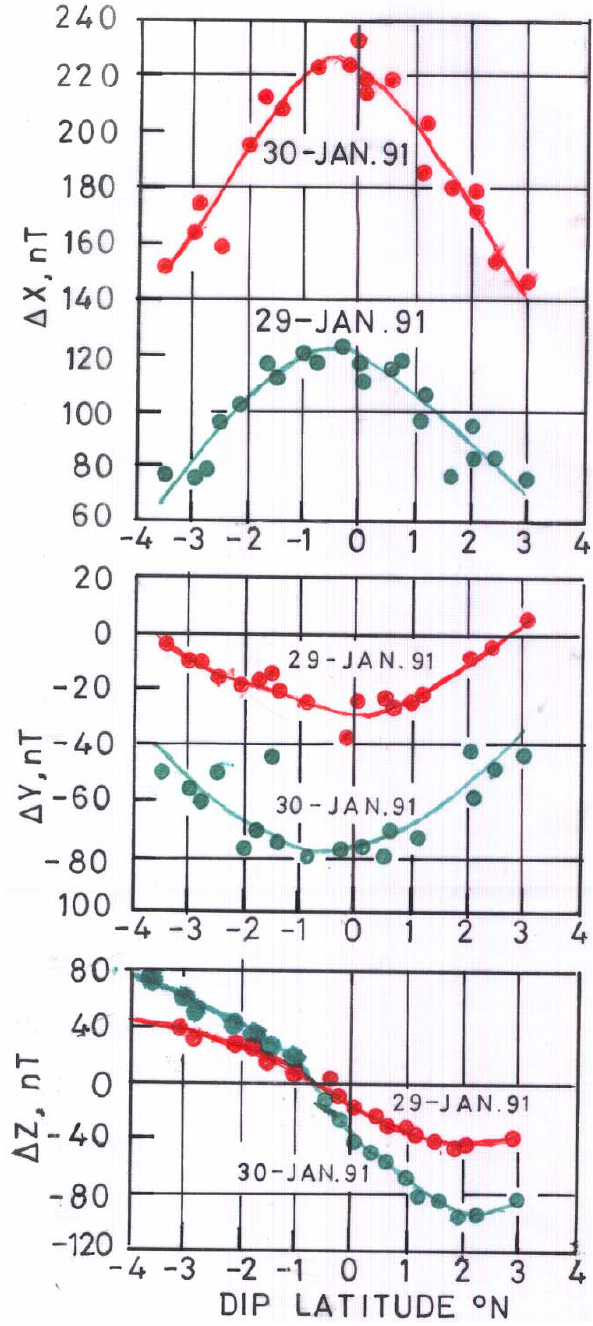
Fig. 7. Dip latitudinal variations of daily ranges of X , Y and Z on a strong (30 January 1991) and on a weak (29 January 1991) electrojet